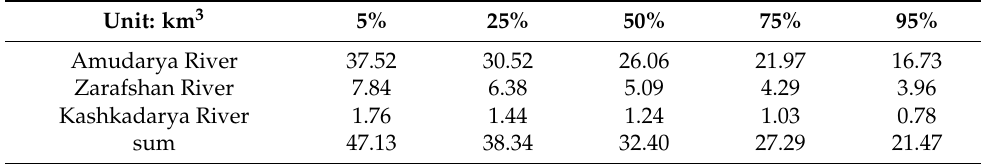
Table 3. Water supply under different guaranteed rates.